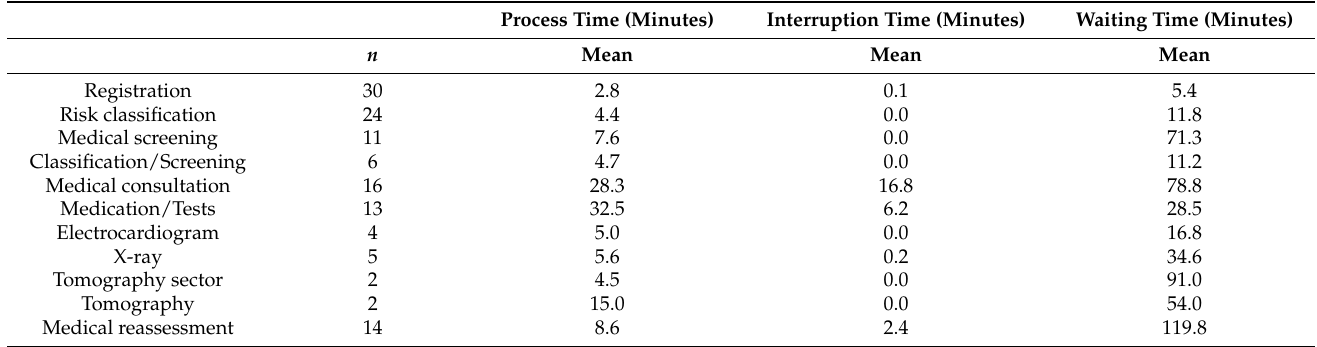
Table 3. Mean process, interruption, and waiting times of each activity involved in the process ( n = 30).